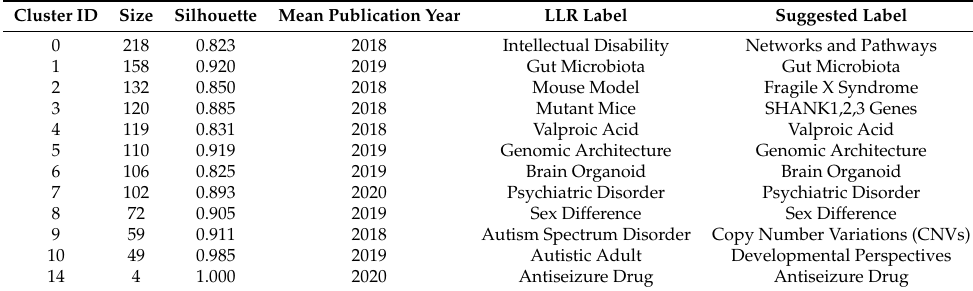
Figure 2. Network of publications generated through the Document Co-Citation Analysis (DCA) on the literature about the genetics of autism from 2018 to 2022. The major clusters are highlighted and divided by color. Table 1. Details of the 12 major clusters identified with the document co-citation analysis (DCA). Log-Likelihood Ratio (LLR) label is automatically generated by the